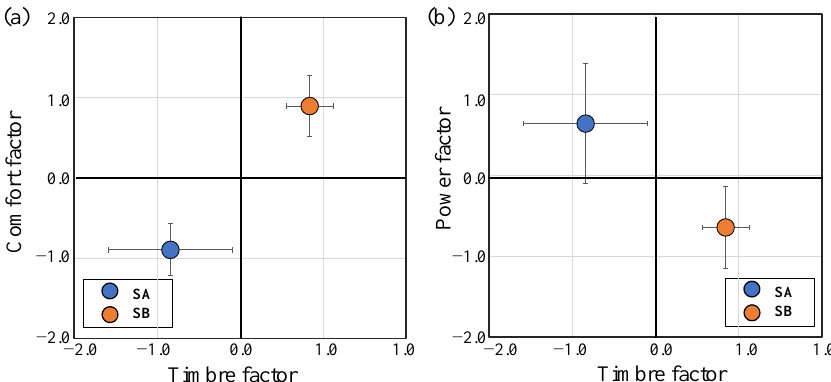
Figure 7. Relationship of the averaged factor scores and SDs between ( a ) beauty and timbre factors, and ( b ) timbre and power factors, respectively. These scores of SA (white noise) and SB (murmuring river sound) contrast with each other, and white noise and murmuring river sounds can be separately perceived as uncomfortable and comfortable sounds.